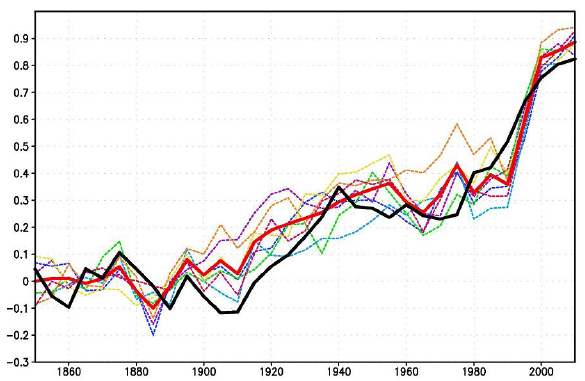
Figure 1. The 5-year mean GMST (K) anomaly with respect to 1850–1899 for HadCRUTv4 (thick solid black); model mean (thick solid red). Dashed thin lines represent data from individual model runs: 1 – purple, 2 – dark blue, 3 – blue, 4 – green, 5 – yellow, 6 – orange, 7 – magenta. In this and the next figures numbers on the time axis indicate the first year of the 5-year mean.